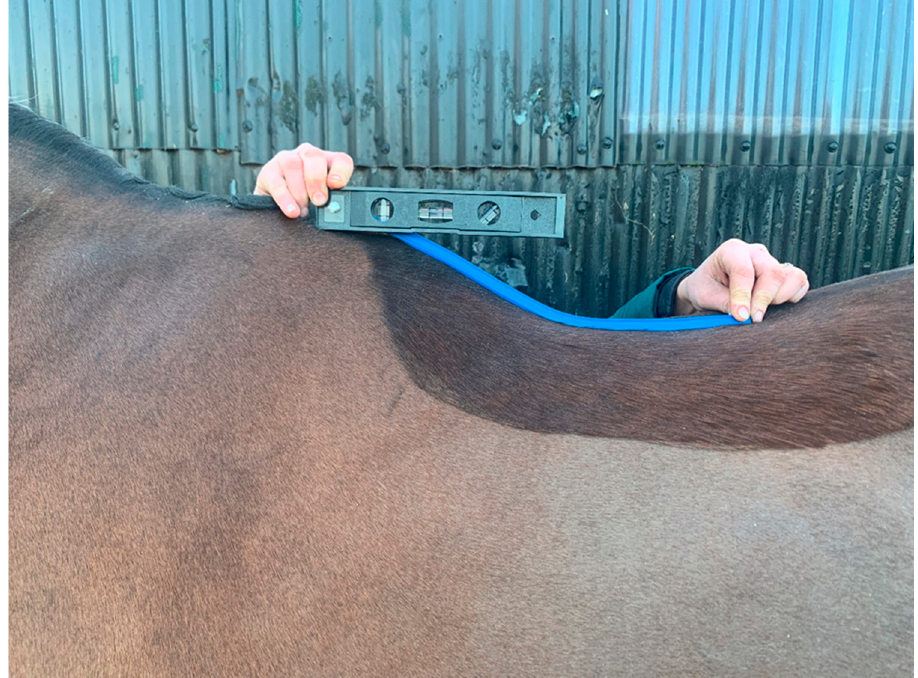
Figure 1. The adapted flexicurve ruler placed on the horse’s spine in a sagittal plane to measure thoracolumbar shape. The spirit level is aligned to horizontal and butterfly nut tightened to retain the flexicurve’s orientation to the horizontal, before removal to trace sagittal profile.